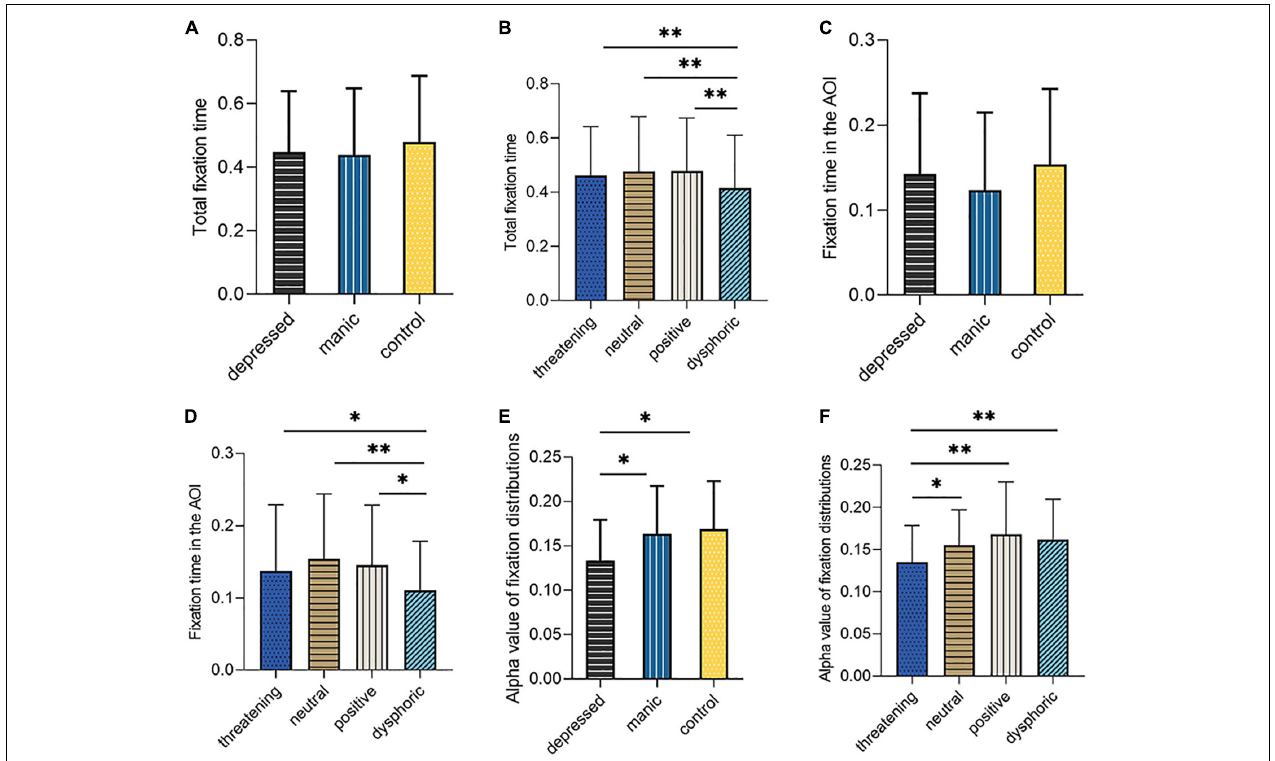
FIGURE 2 | The schematic illustration in (A) shows total fixation time according to different groups, in (B) shows total fixation time according to different stimulus type, in (C) shows AOI fixation time according to different groups, in (D) shows AOI fixation time according to different stimulus type, in (E) shows the alpha value of fixation distribution according to different groups, in (F) shows the alpha value of fixation distribution according to different stimulus type. ∗ Significant difference at p < .05. ∗∗ Significant difference at p < 0.01.